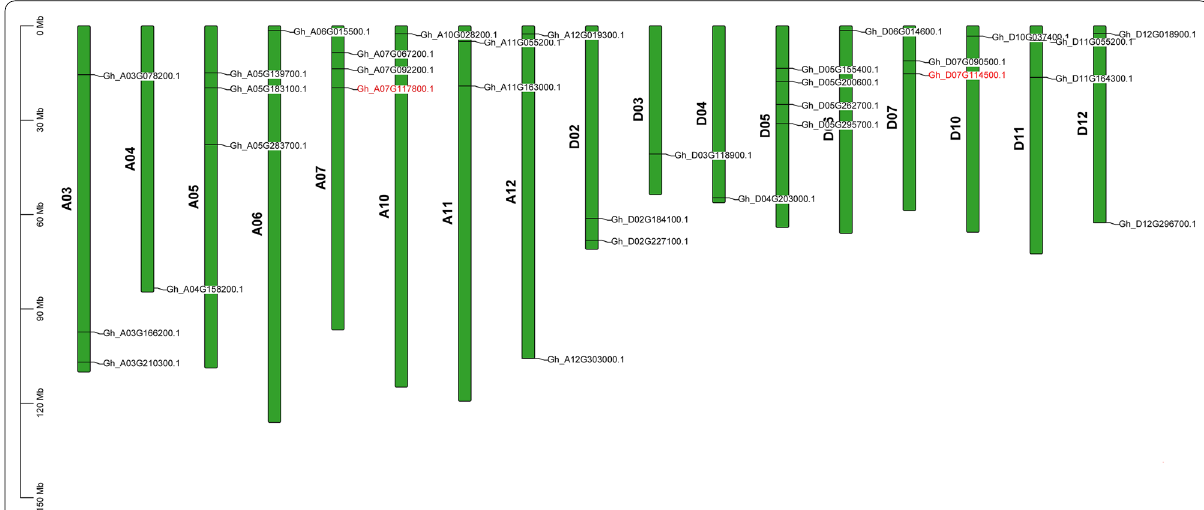
Fig. 2 Chromosomal locations of NAT genes in Gossypium